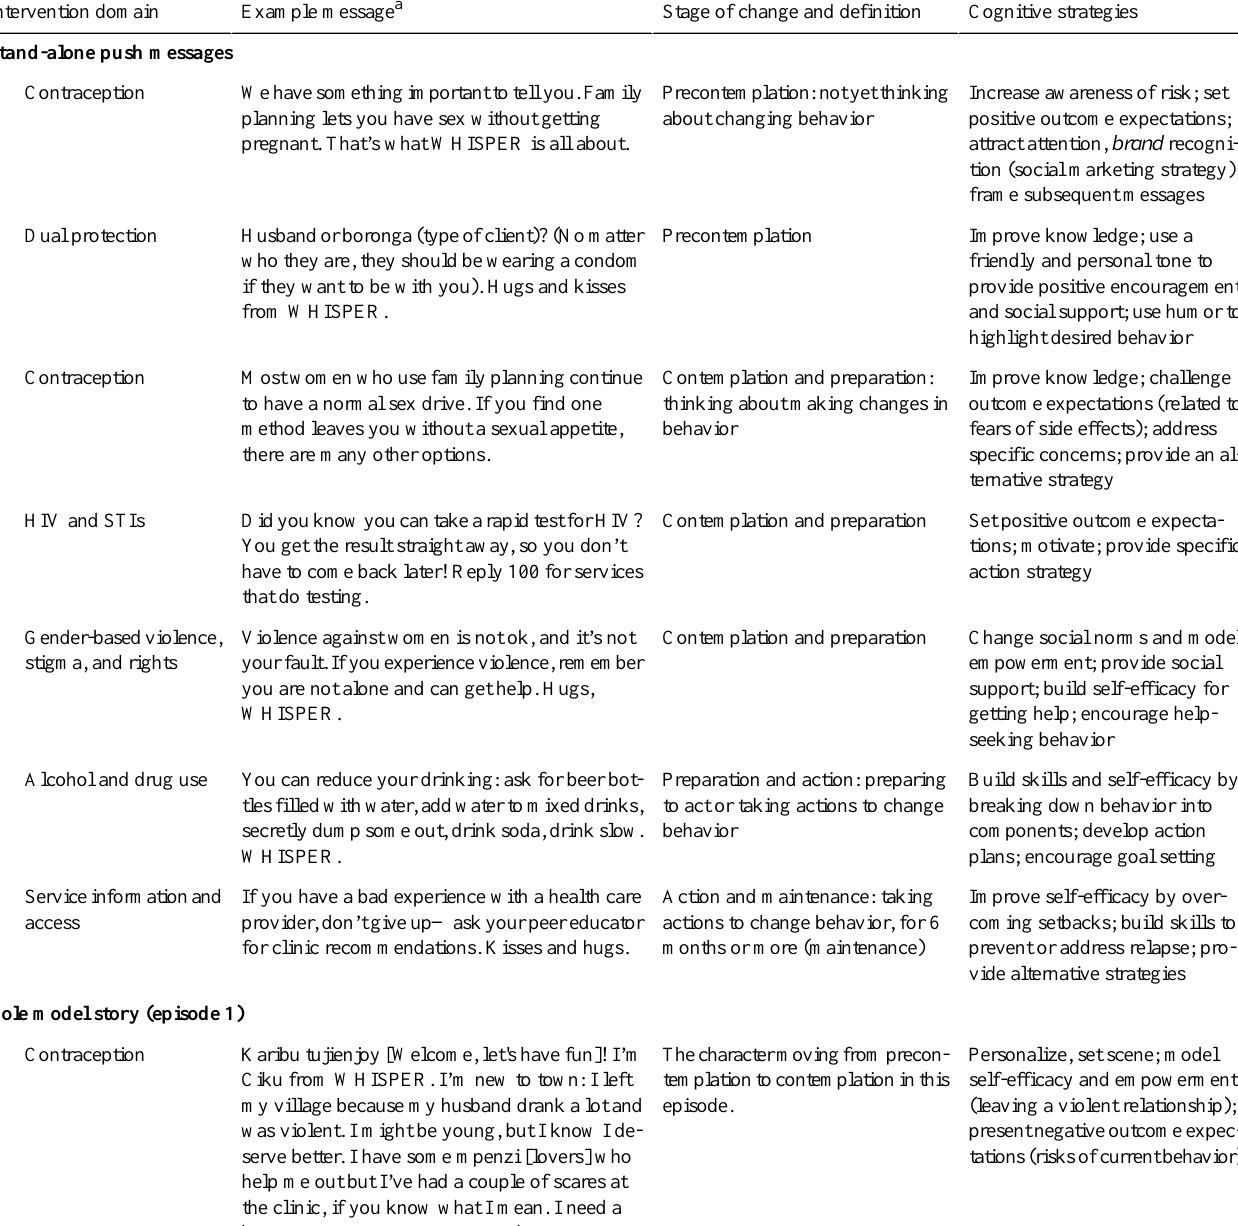
Table 1. Example messages and a role model story episode mapped to behavior change theory and